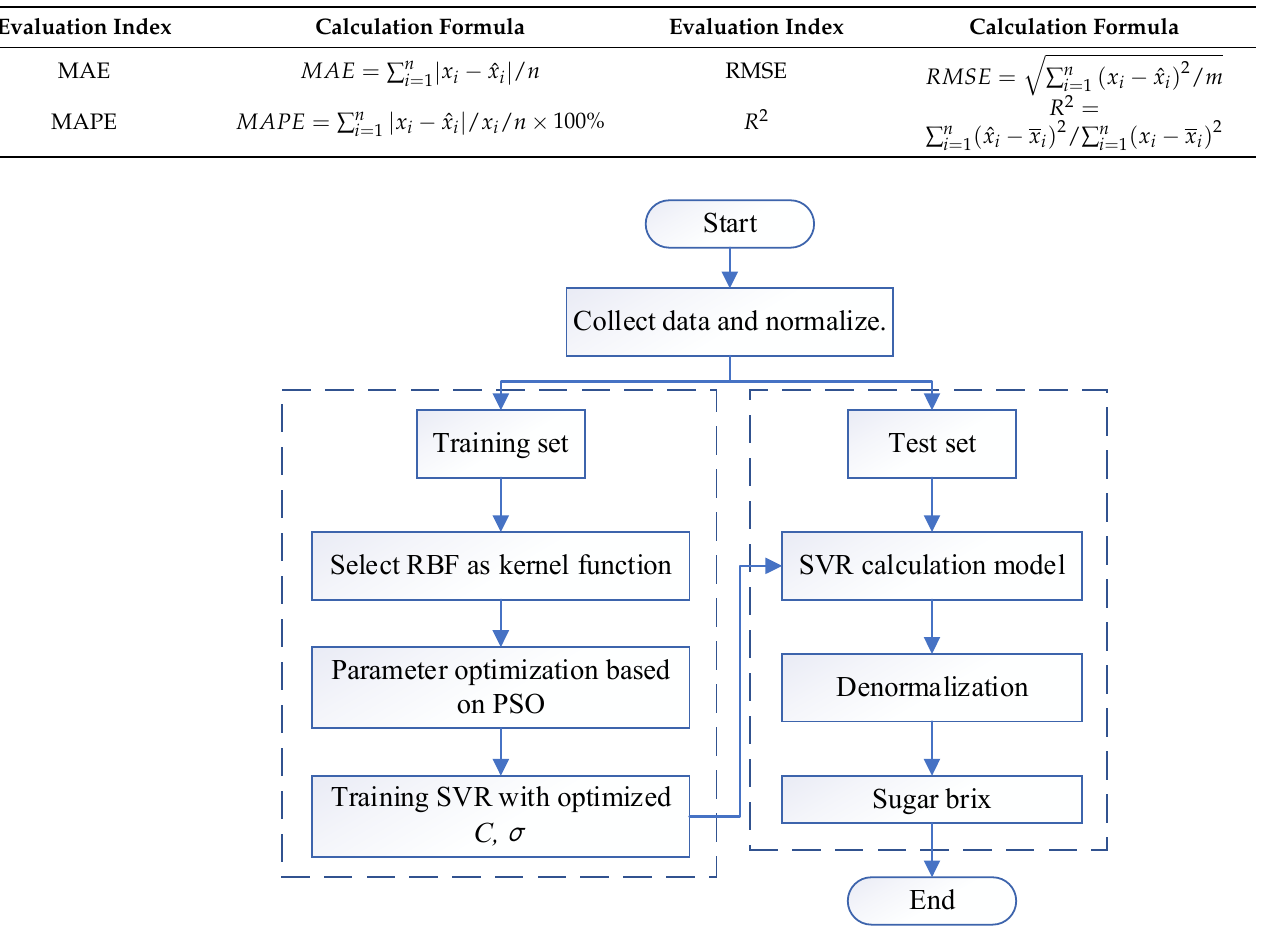
Figure 4. Model of syrup brix measurement based on PSO–SVR.